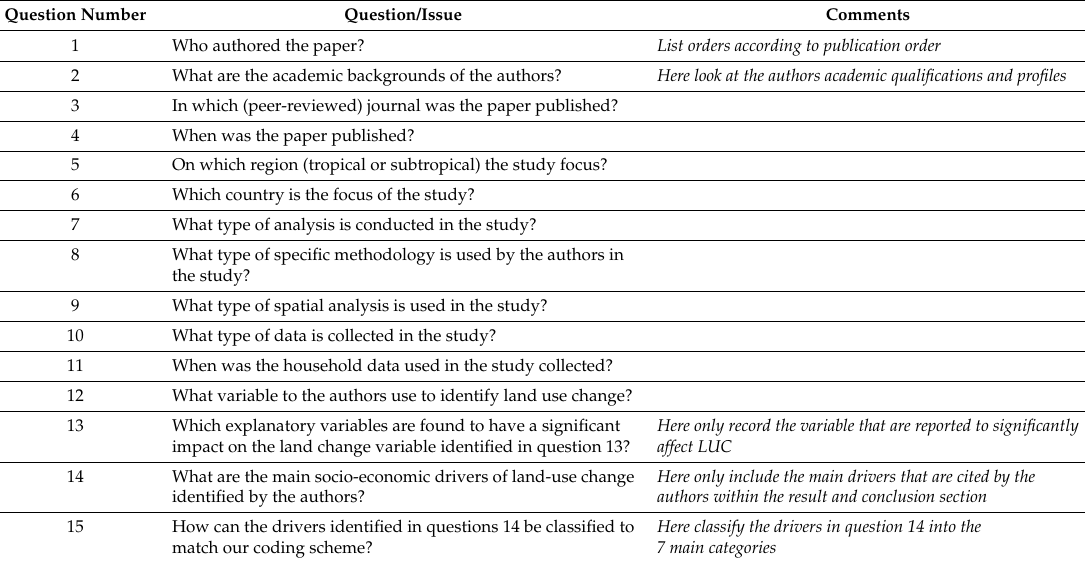
Table A1. Review